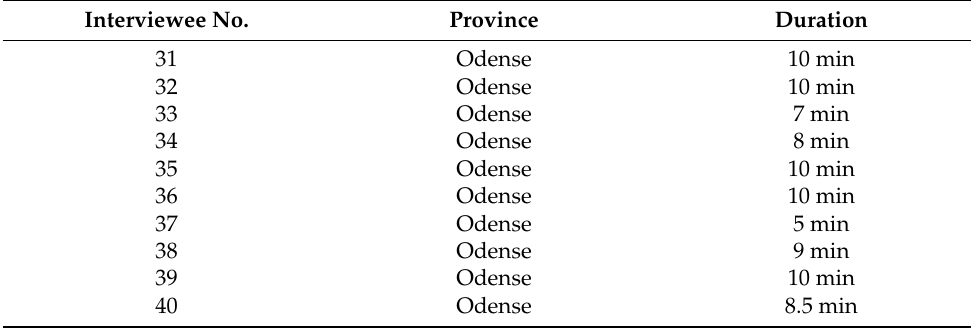
Table A4. Interviews and Interviewees of Danish Participants: Segment 1. Interviewee No.